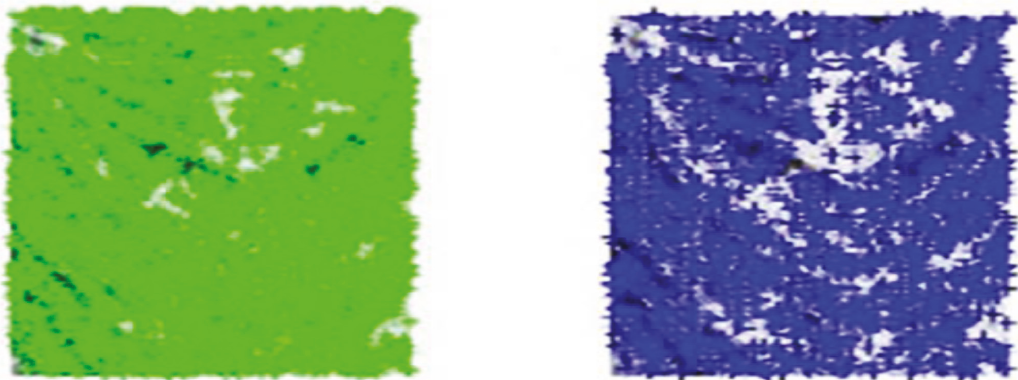
Figure 11: Output graph showing key points that perfectly